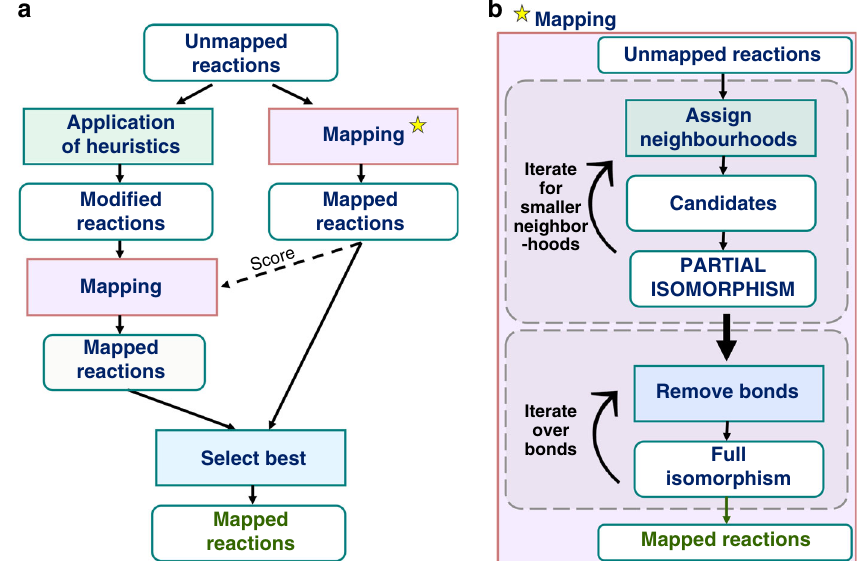
Fig. 3 Algorithm scheme. a A diagram illustrating the algorithm with (left arm of the fl owchart) and without (right arm) the use of heuristics. Both paths are processed simultaneously — in the end, the scores are compared and a lower-scoring solution is selected. The purpose of additionally performing the search without heuristics is that the best solution it produces (with some score S, communicated from the right to the left branches; dotted arrow) allows rapid rejection of any other with-heuristics solutions for which the score is above S. This allows the algorithm to signi fi cantly limit the search space and yield results faster. b A scheme of the mapping procedure, in which two iterative processes are involved: iteration for smaller neighborhoods and iteration over bonds — see main text for